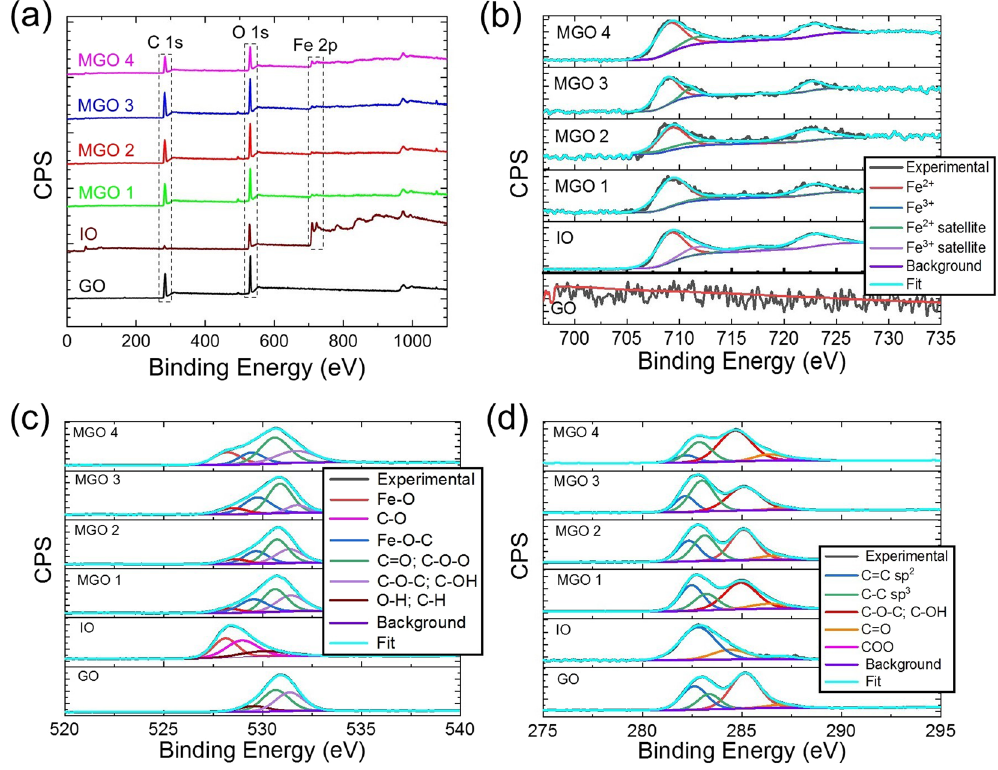
Figure 4. ( a ) XPS survey spectra of GO, IO, and MGOs. High resolution ( b ) Fe 2p spectra, ( c ) O 1s and ( d ) C 1s spectra of GO, IO, and MGOs with the experimental and deconvolution